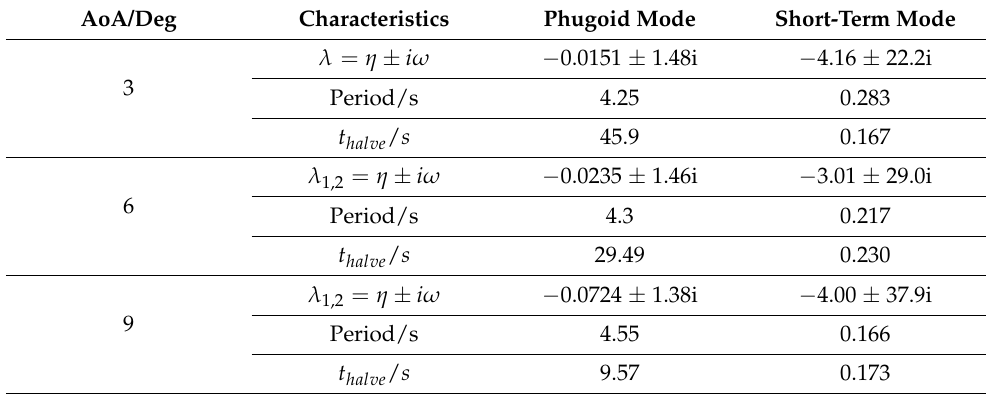
Table 5. Characteristics of longitudinal stability at three angles of